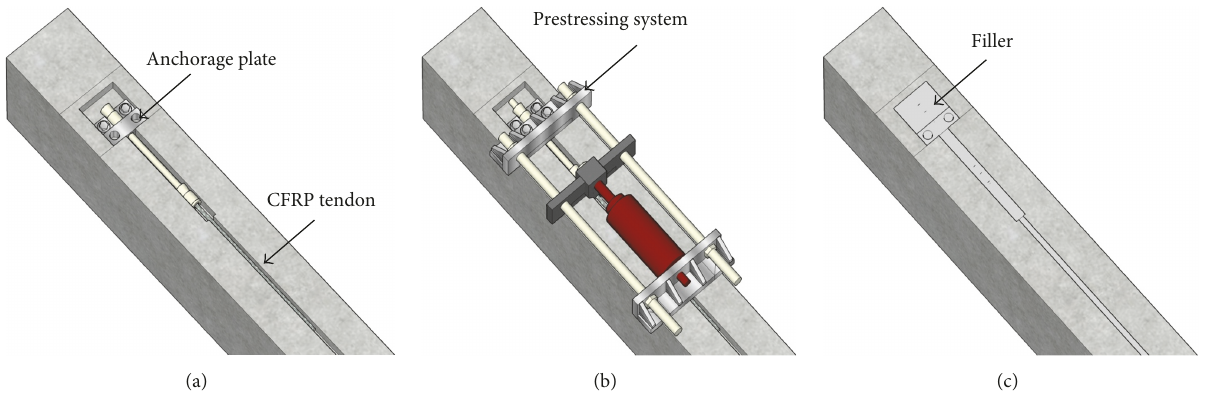
Figure 4: Concept of the new prestressing system developed in this study.